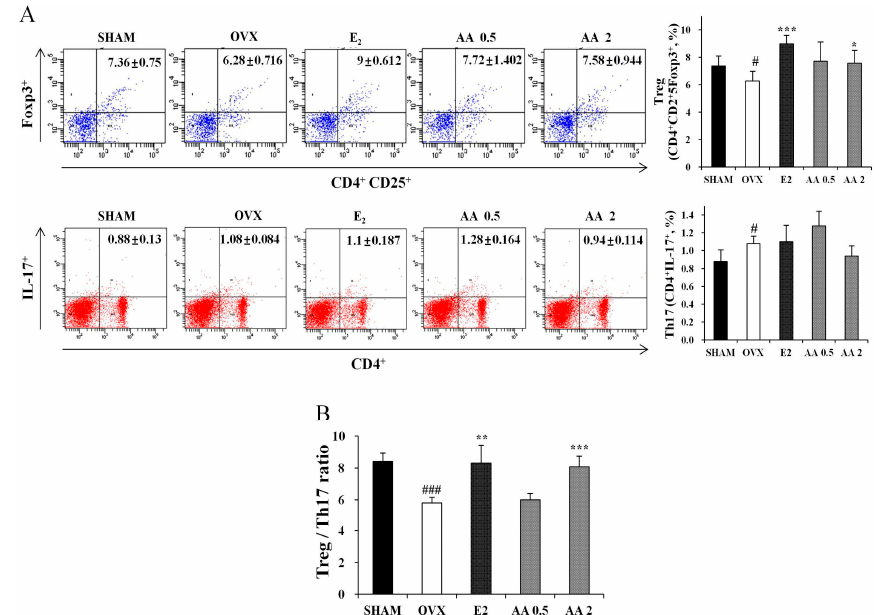
Figure 2. AA treatment increase Treg cells and decrease Th17 cell. ( A ) After the isolation of splenocytes from AA treated mice or vehicle treated mice, the populations of IL-17 producing CD4+ T cells, and Foxp3 producing C25+ T cells were analyzed using antibodies specific for CD4, CD25, Foxp3 and IL-17 by intracellular flow cytometric analysis. ( B ) Treg/Th17 ratio. Each value represents the mean ± SD for n = 5. # p < 0.05 and ### p < 0.001, significantly different from sham mice. * p < 0.05, ** p < 0.01 and *** p < 0.001, significantly different from OVX mice.